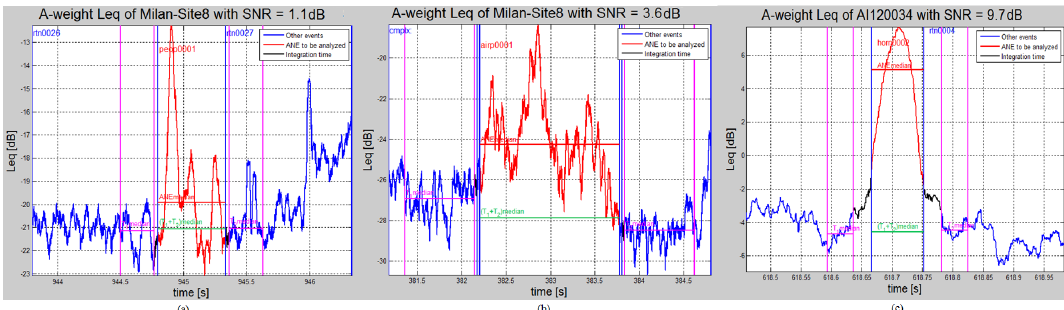
Figure 7. Examples of SNR labeling of three anomalous noise events. From left to right: ( a ) a low-salient ANE (people talking in the street, measured in a Milan street, with SNR = 1.1 dB); ( b ) a medium-salient ANE (the sound of an airplane measured in another Milan road, with SNR = 3.6 dB); and ( c ) a high-salient ANE (sound of a horn measured along the A90 motorway in Rome, with SNR = 9.7 dB). x -axis corresponds to time in seconds referenced to the start point of the